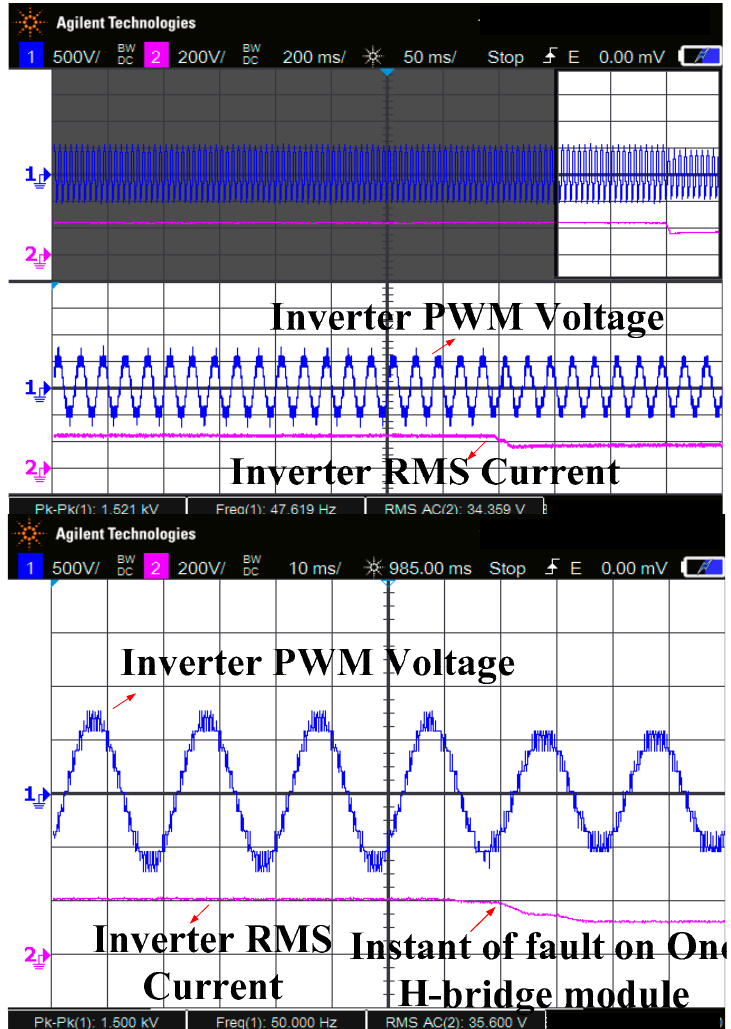
Figure 12. Inverter PWM voltage and RMS current during a fault in one H-bridge module